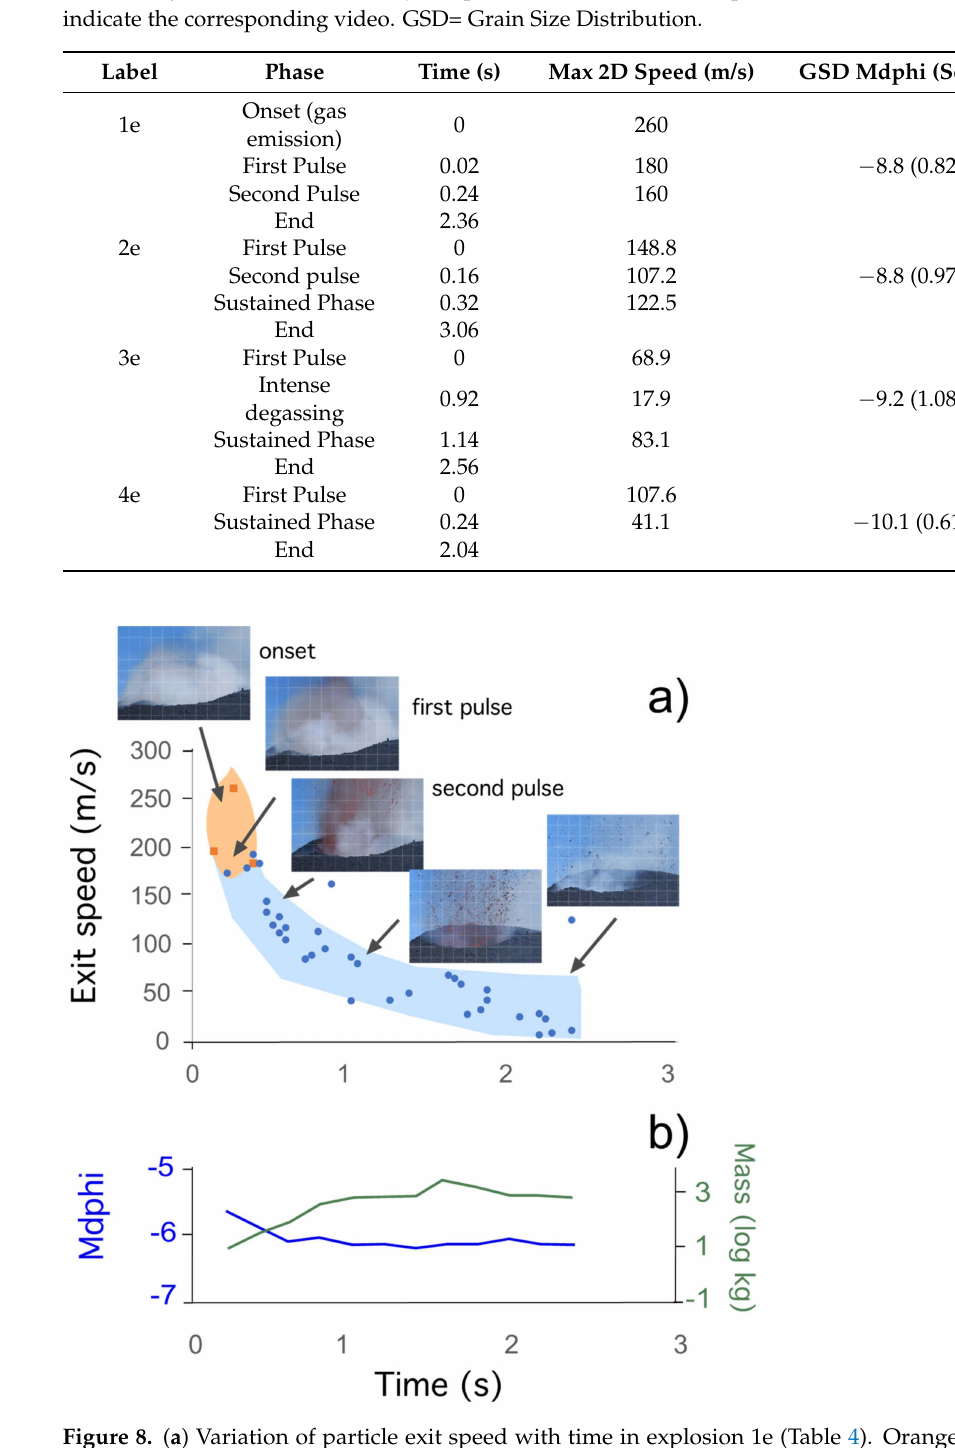
Figure 8. ( a ) Variation of particle exit speed with time in explosion 1e (Table 4). Orange squares: gas stream velocity, blue dots, particle velocity. Data uncertainty is highlighted by colored areas; ( b ) variation of measured Mdphi and instantaneous emitted mass with time. The explosions start with a weak gas emission which is not recorded in these